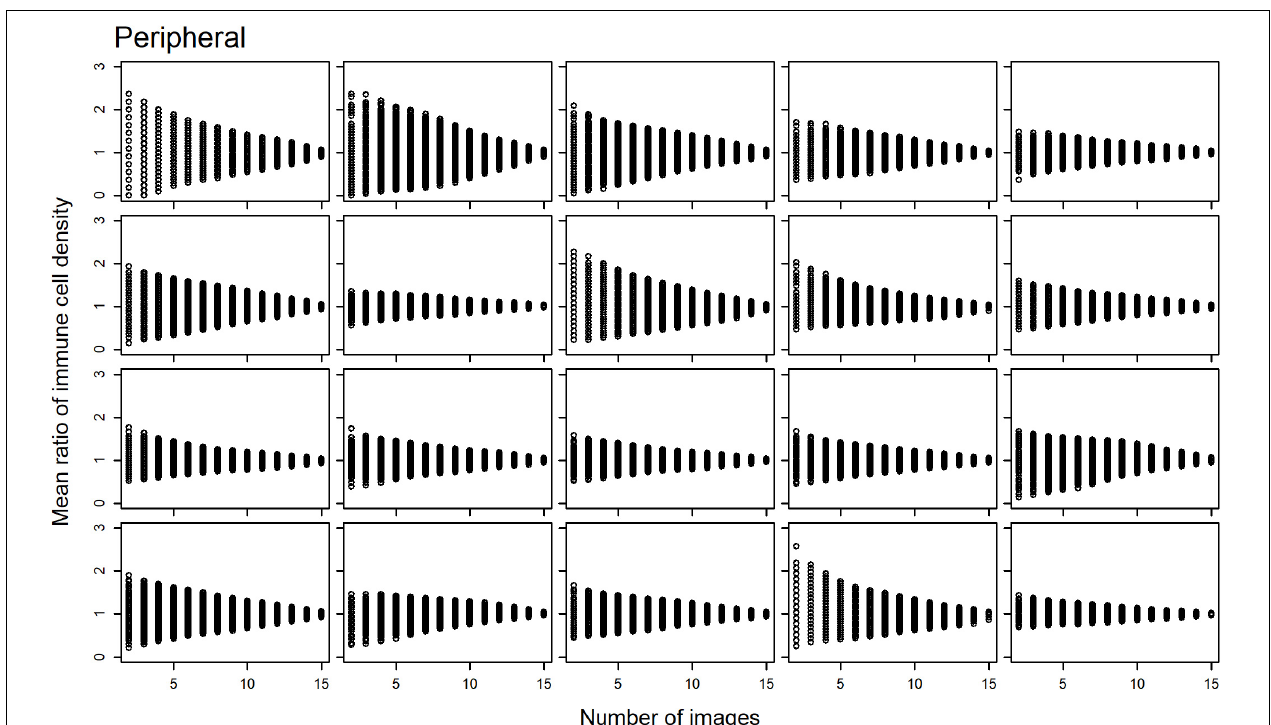
FIGURE 3 | Scatterplots of the mean ratio for corneal epithelial immune cell (IC) density relative to the number of randomly selected, non-overlapping IVCM images used for the density estimate for each participant, in the peripheral cornea.